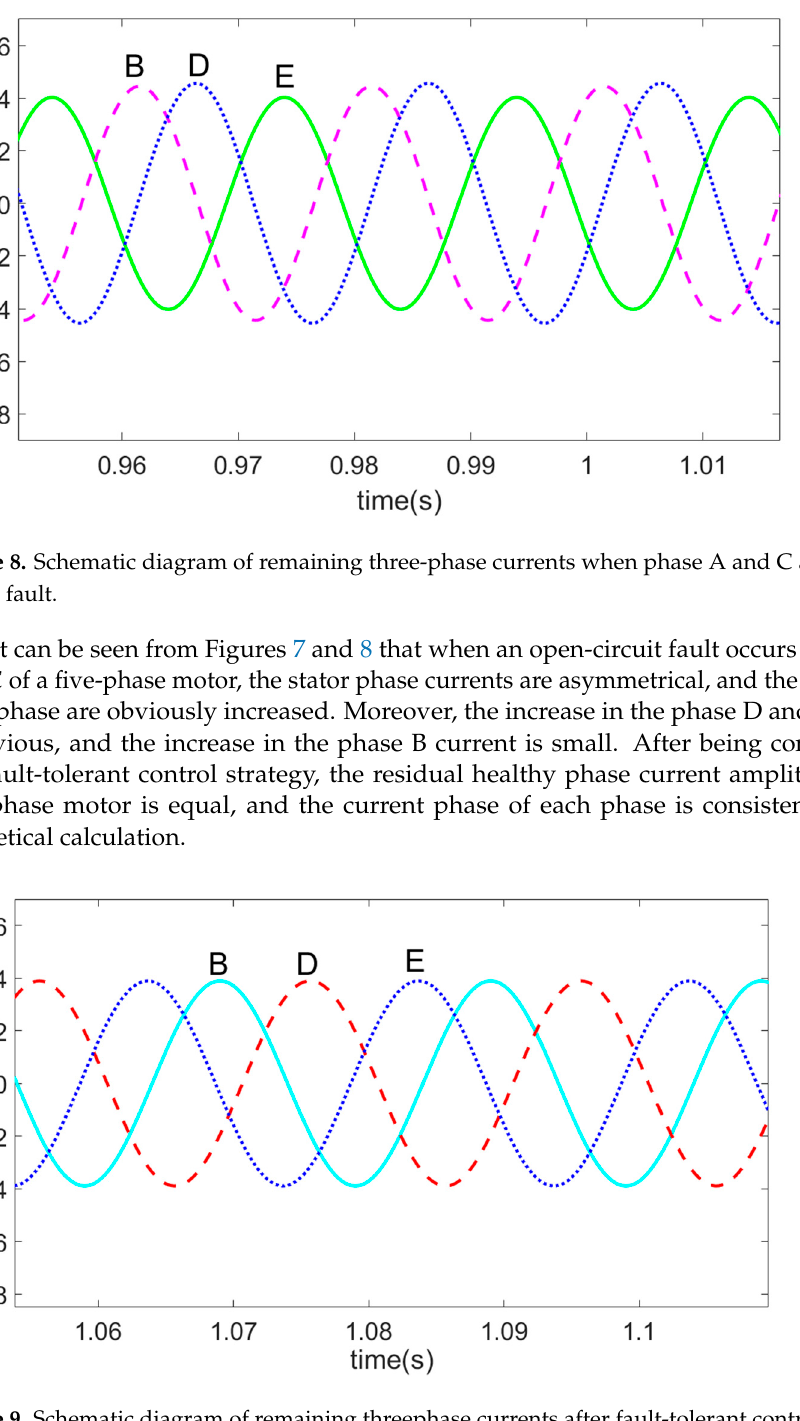
Table 2. Experimental parameters of five − phase induction motor.